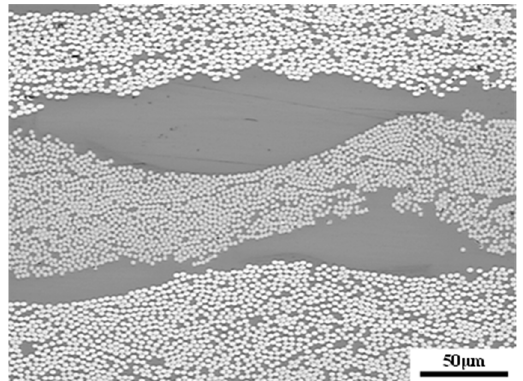
Figure 6. Optical micrograph of distribution and morphology of toughening agent of dot-matrix- toughened structure. toughened structure.